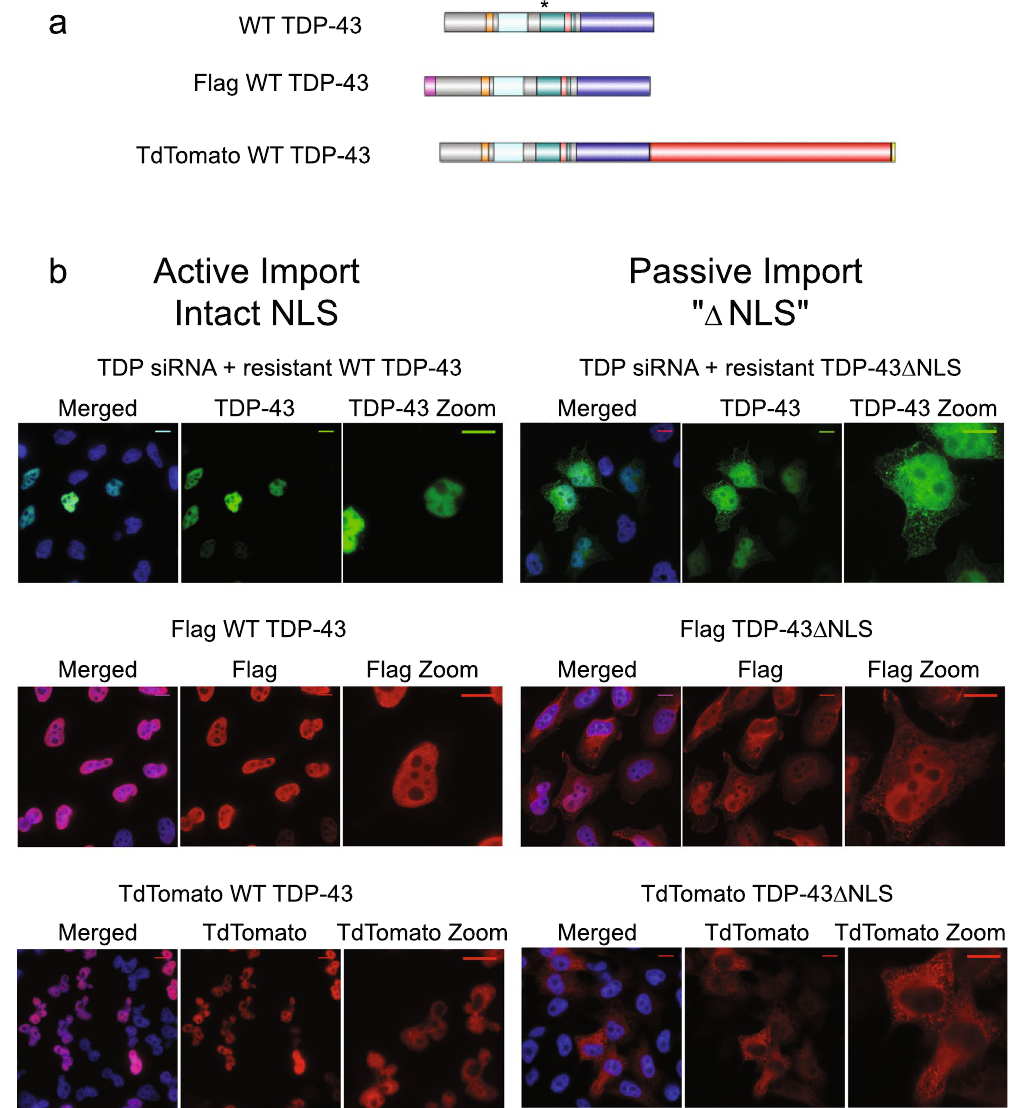
Figure 7. Addition of a bulky tag on TDP-43 disrupts passive but not active nuclear import. ( a ) Domains maps (to scale) of WT TDP-43 containing synonymous mutations which confer resistance to TDP-43 siRNA (indicated by asterisk), Flag WT TDP-43, tdTomato TDP-43. Formatted using IBS cuckoo 43 . ( b ) Immunofluorescence of HeLa cells expressing the indicated protein. Selected samples were treated with TDP-43 siRNA to deplete endogenous TDP-43. Resistant TDP-43 was visualized via immunofluorescence with TDP- 43 antibody; Flag TDP-43 was visualized via immunofluorescence with Flag antibody; tdTomato TDP-43 was visualized with direct fluorescence. Nuclei were visualized using Hoechst stain. Scale bar- 10 um. Images are representative of 3 independent